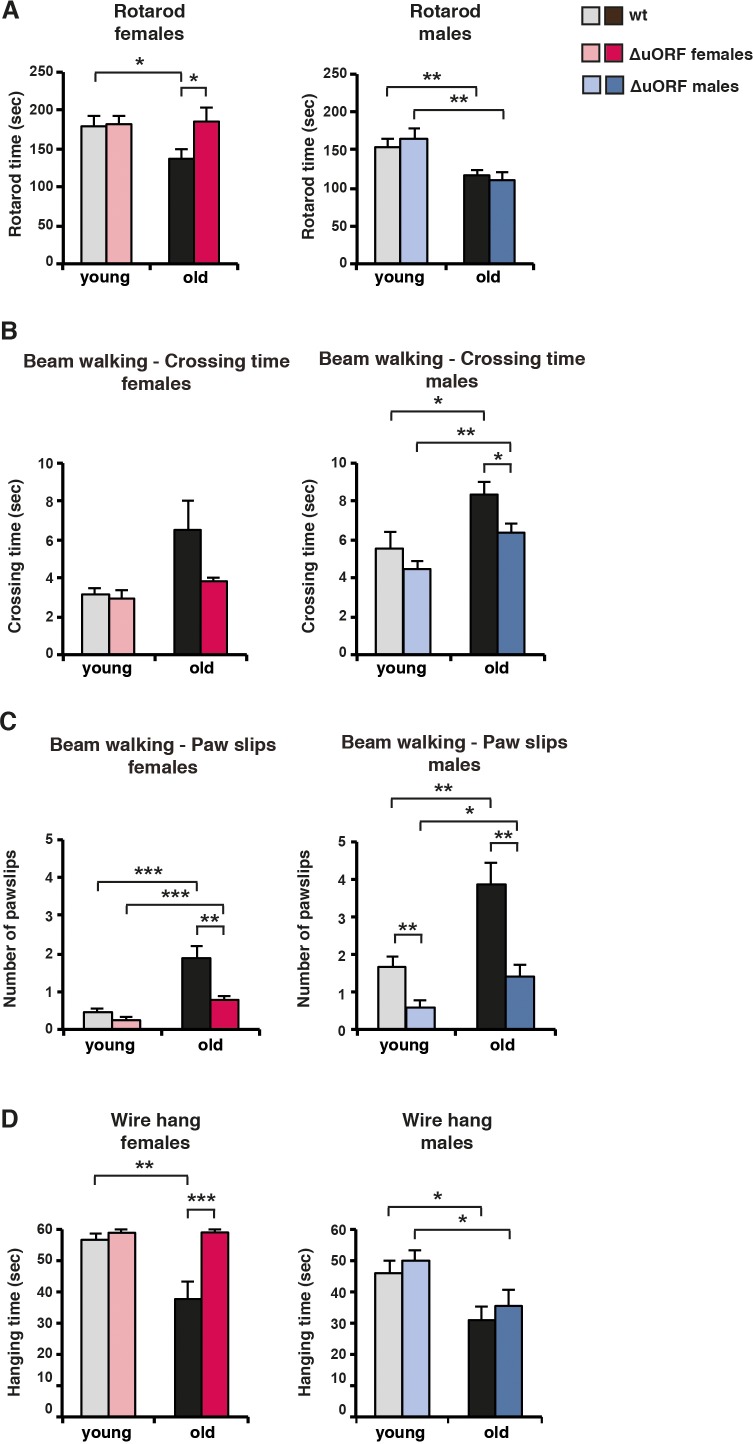
Ageing-associated loss of motor coordination and grip strength is attenuated in C/EBPβΔuORF mice.(A) Rotarod performance (time in sec of stay on the rotarod) of young (4 months) and old (female 19 months, male 21 months) wt and C/EBPβΔuORF mice is shown separately for females (left) and males (right) (wt females, n = 11 young, n = 12 old; wt males, n = 12 young and old; C/EBPβΔuORF females, n = 11 young, n = 12 old; C/EBPβΔuORF males, n = 12 young, n = 11 old). (B) The crossing time (sec) of the beam walking test of young and old wt and C/EBPβΔuORF mice, and (C) the number of mistakes (paw slips) made while crossing the beam is shown separately for females and males (wt females, n = 11 young, n = 12 old; wt males, n = 12 young and old; C/EBPβΔuORF females, n = 11 young, n = 12 old; C/EBPβΔuORF males, n = 12 young, n = 10 old). (D) Grip strength as determined with the wire hang test as hanging time (sec) of young and old wt and C/EBPβΔuORF mice for females and males separately. N = 11 for young wt and C/EBPβΔuORF females and for old C/EBPβΔuORF females and n = 12 for old wt females; n = 11 for young and old wt males; n = 12 for young C/EBPβΔuORF males and n = 10 for old C/EBPβΔuORF males. P-values were determined by Student’s t-test, *p<0.05; **p<0.01; ***p<0.001.